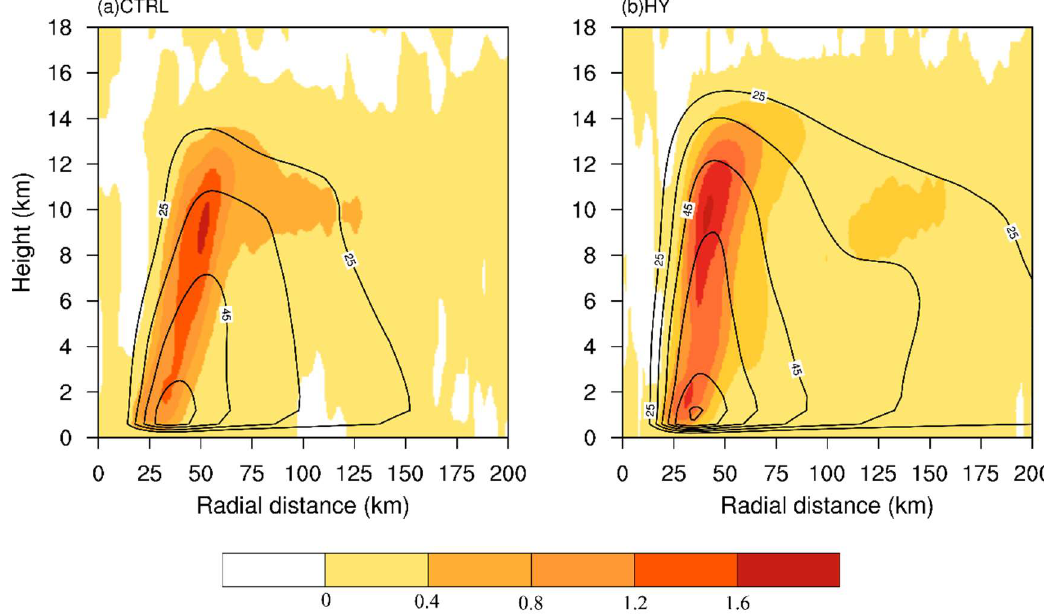
Figure 19. Height–radius cross-sections of the azimuthal mean vertical winds (color shaded, m s − 1 ) and tangential winds (black contours, m s − 1 ) for ( a ) CTRL and ( b ) HY averaged between 84 and 96 h.